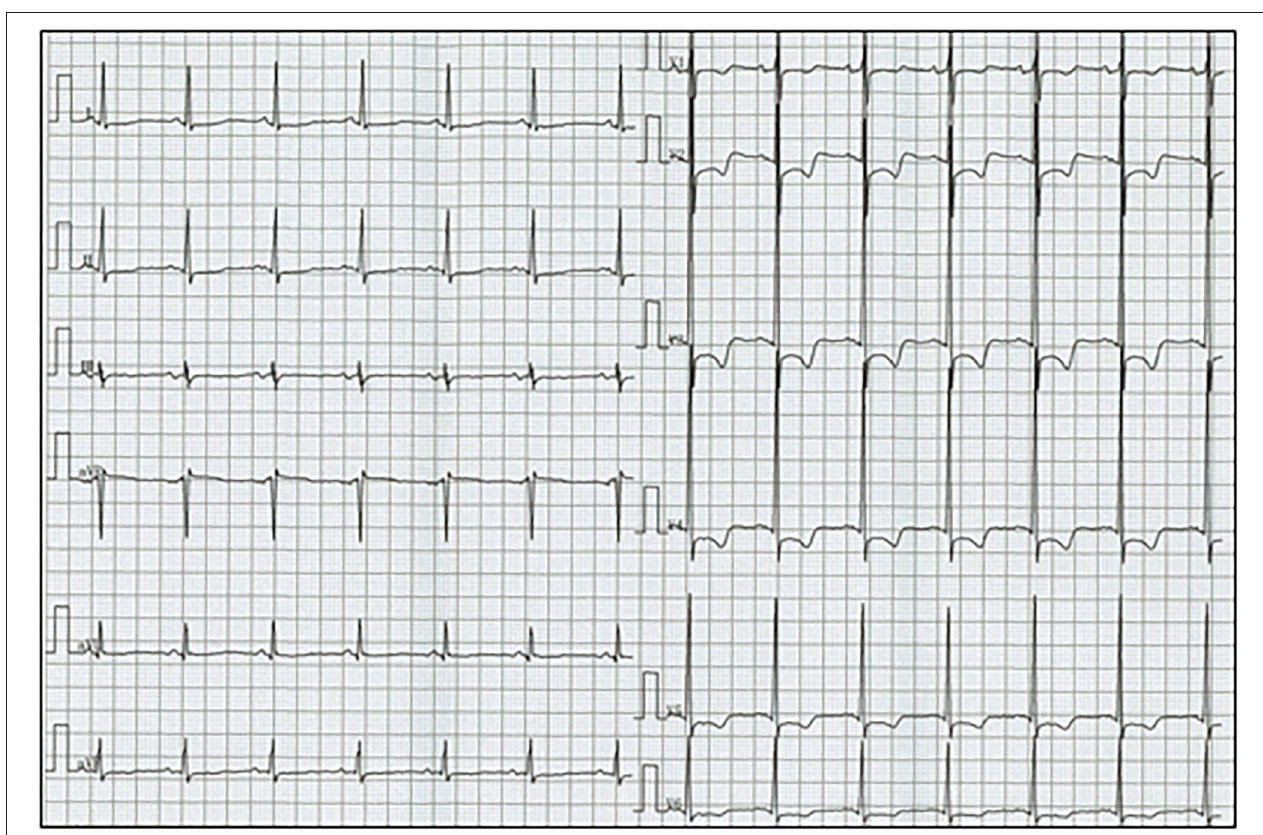
FIGURE 1 | Electrocardiogram reveals sinus rhythm and ST segment depression with T-wave inversion in leads